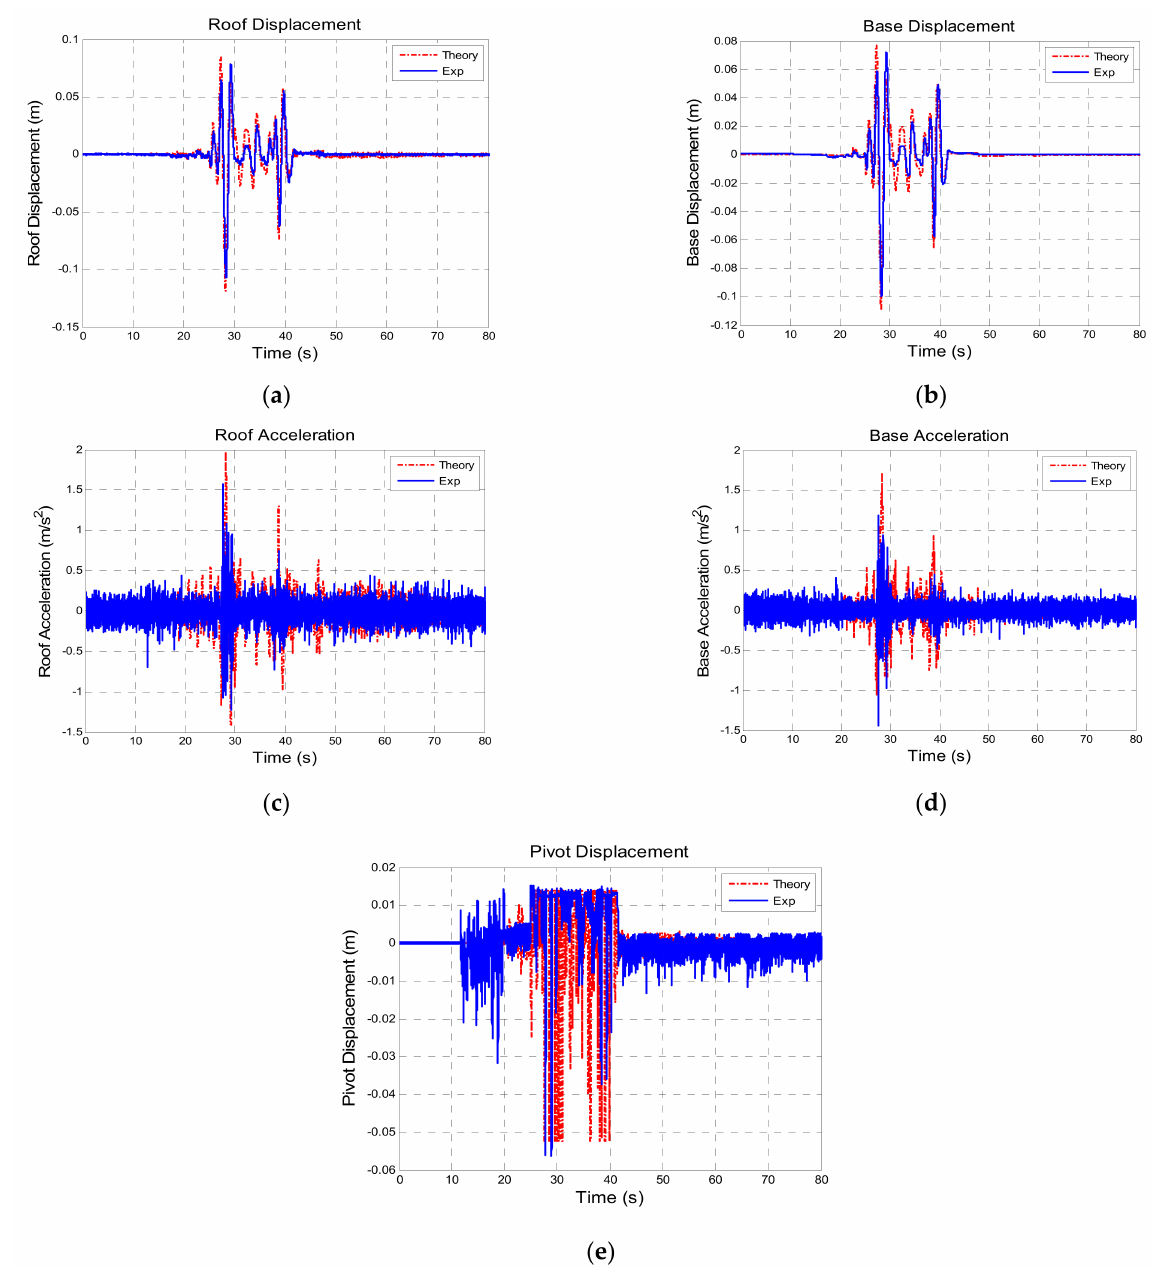
Figure 7. Comparison of the responses between theoretical and experimental values (TCU102-EW PGA = 0.1 g). ( a ) Super- structure displacement. ( b ) Isolation layer displacement. ( c ) Superstructure acceleration. ( d ) Isolation layer acceleration. ( e ) Pivot